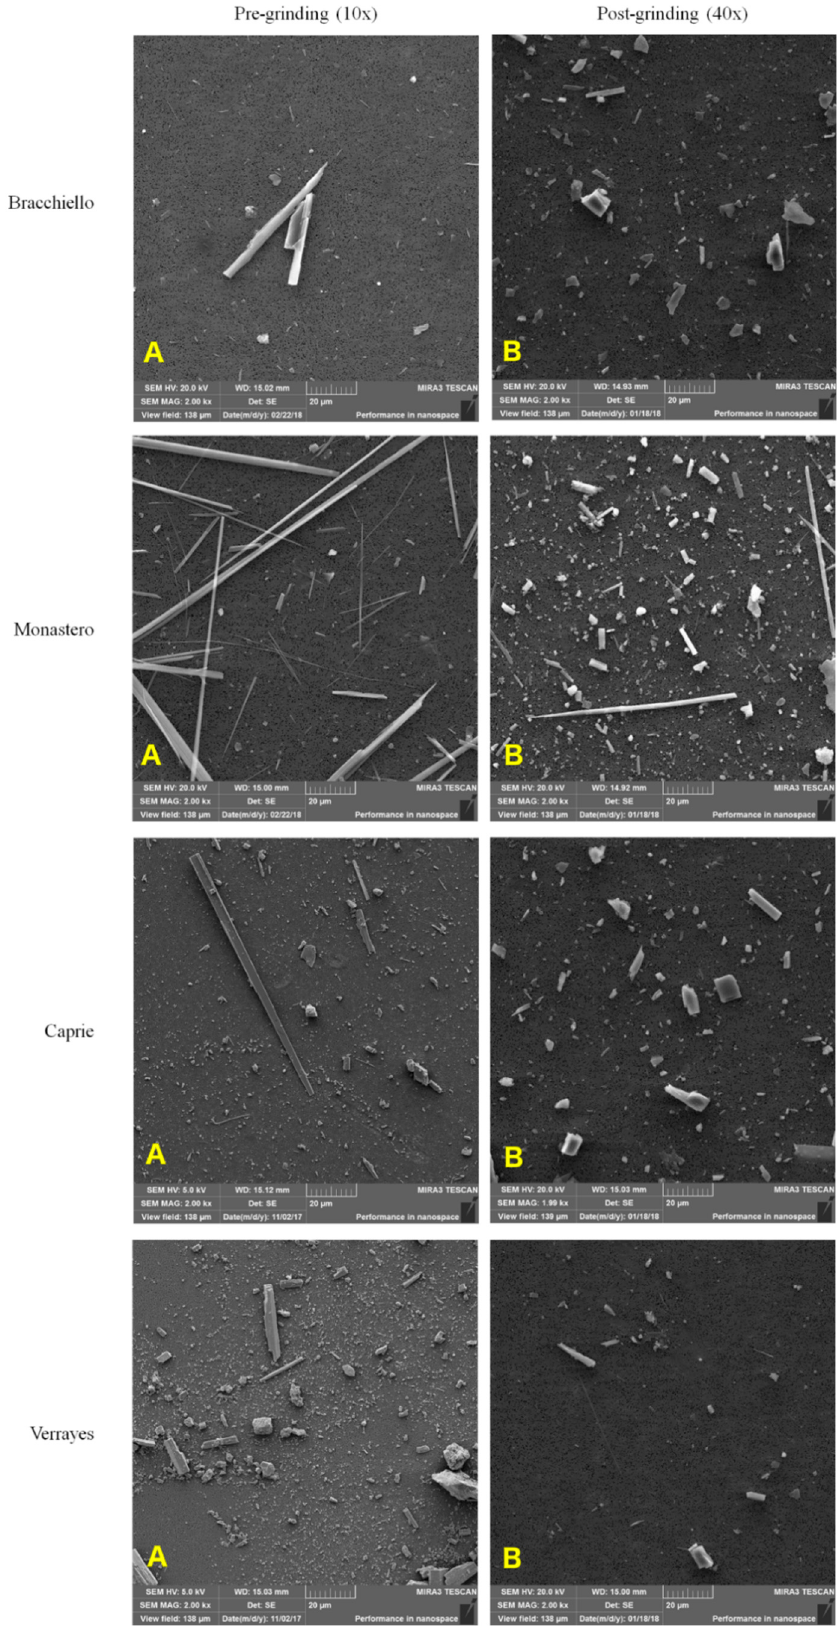
Figure 8. Scanning electron microscope (SEM) images, before ( A ) and after grinding ( B ).